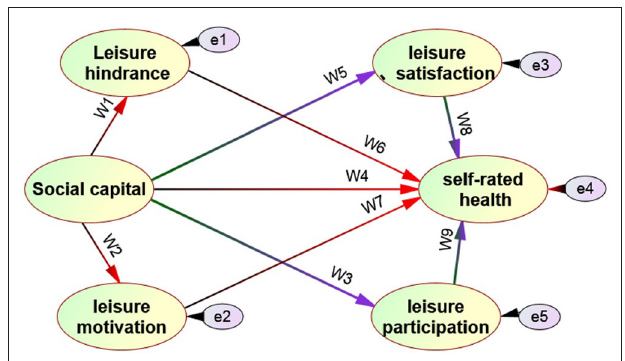
FIGURE 1 | Hypothetical model of the relationship between social captial and leisure behavior on self-rated